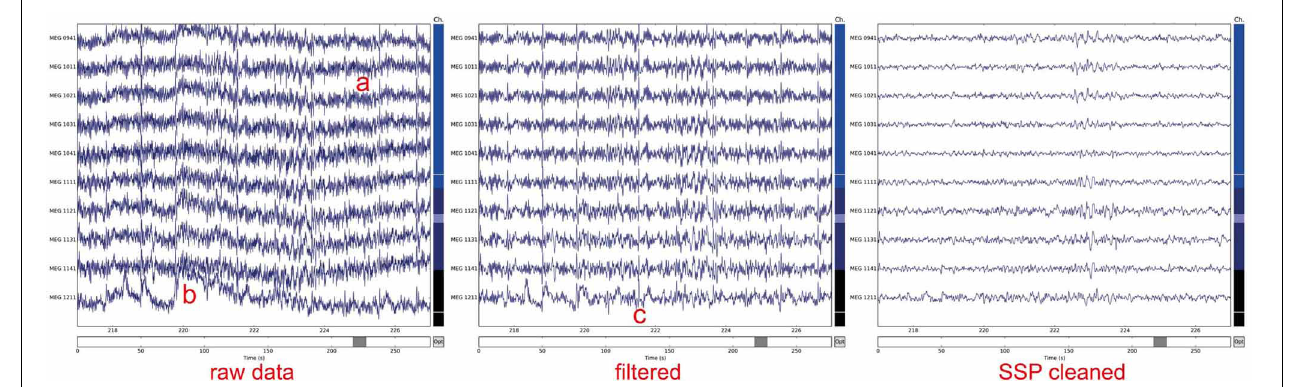
FIGURE 1 | Noisy raw MEG magnetometer signals corrupted by a) slow drifts, b) line noise (at 50 or 60Hz), and c) heartbeats present across sensors. To clean signals data were filtered between 1 and